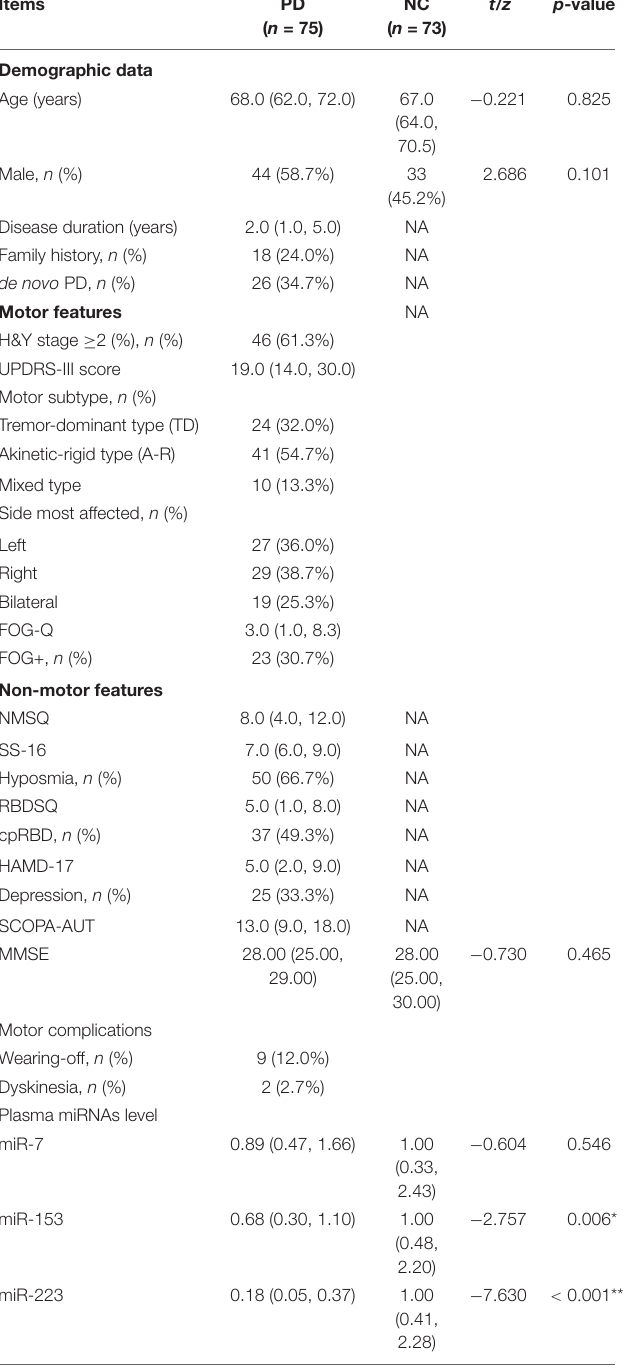
TABLE 1 | General characteristics in patients with PD and